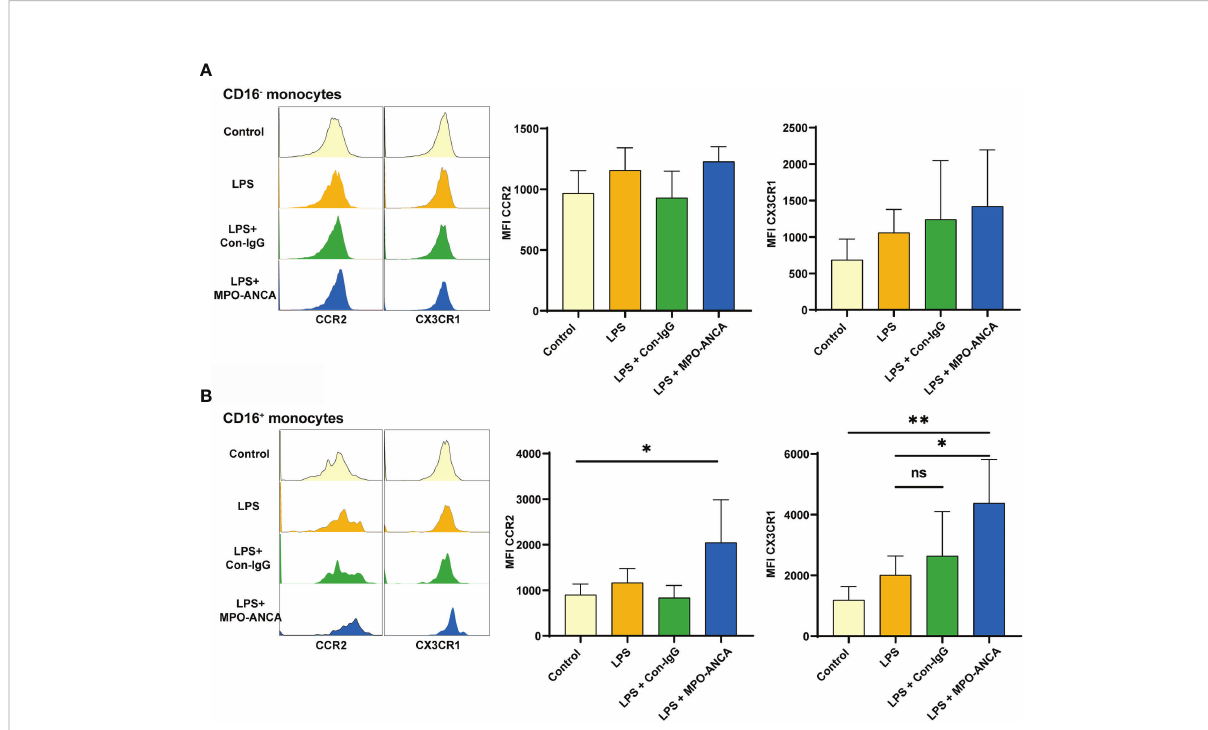
FIGURE 4 CD16 + monocytes show more pronounced CX3CR1 upregulation in response to MPO-ANCA in vitro . Isolated CD16 + and CD16 - monocytes were treated with LPS or combined with MPO-ANCA and Con-IgG for 24h, respectively. Experiments were performed with monocytes from 5 healthy donors; (A) the MFI of CCR2 and CX3CR1 in CD16 - monocytes after stimulation; (B) the MFI of CCR2 and CX3CR1 in CD16 + monocytes after stimulation. * p <0.05; ** p <0.01. ns, not signi fi